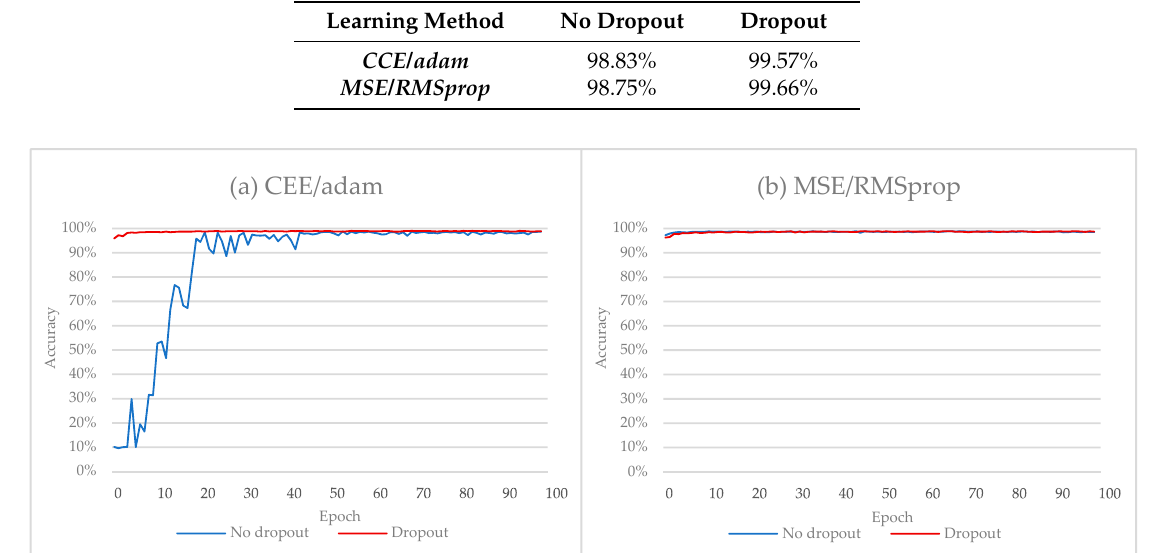
Table 4. Experimental results on the ADBase database. CCE: cross-entropy error; MSE: mean square error.